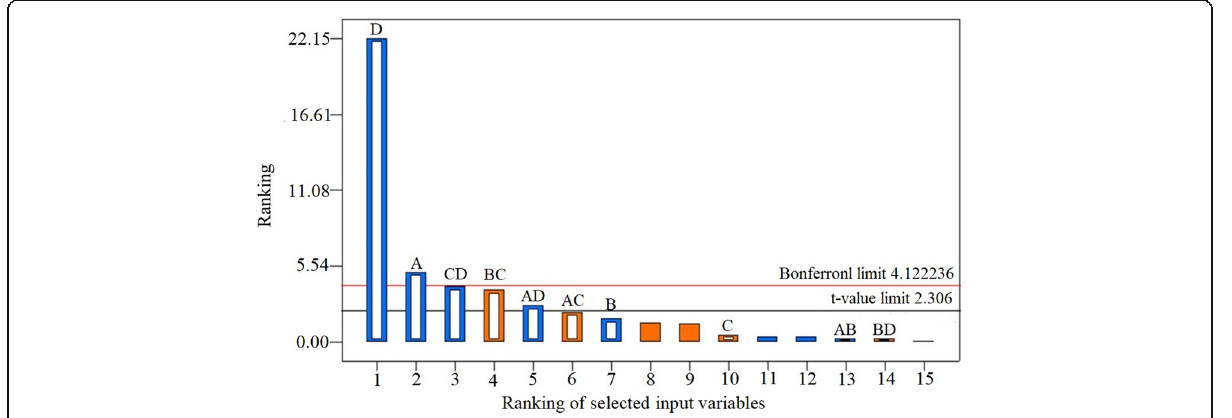
Fig. 3 Pareto chart showing the ranking of the selected input variables